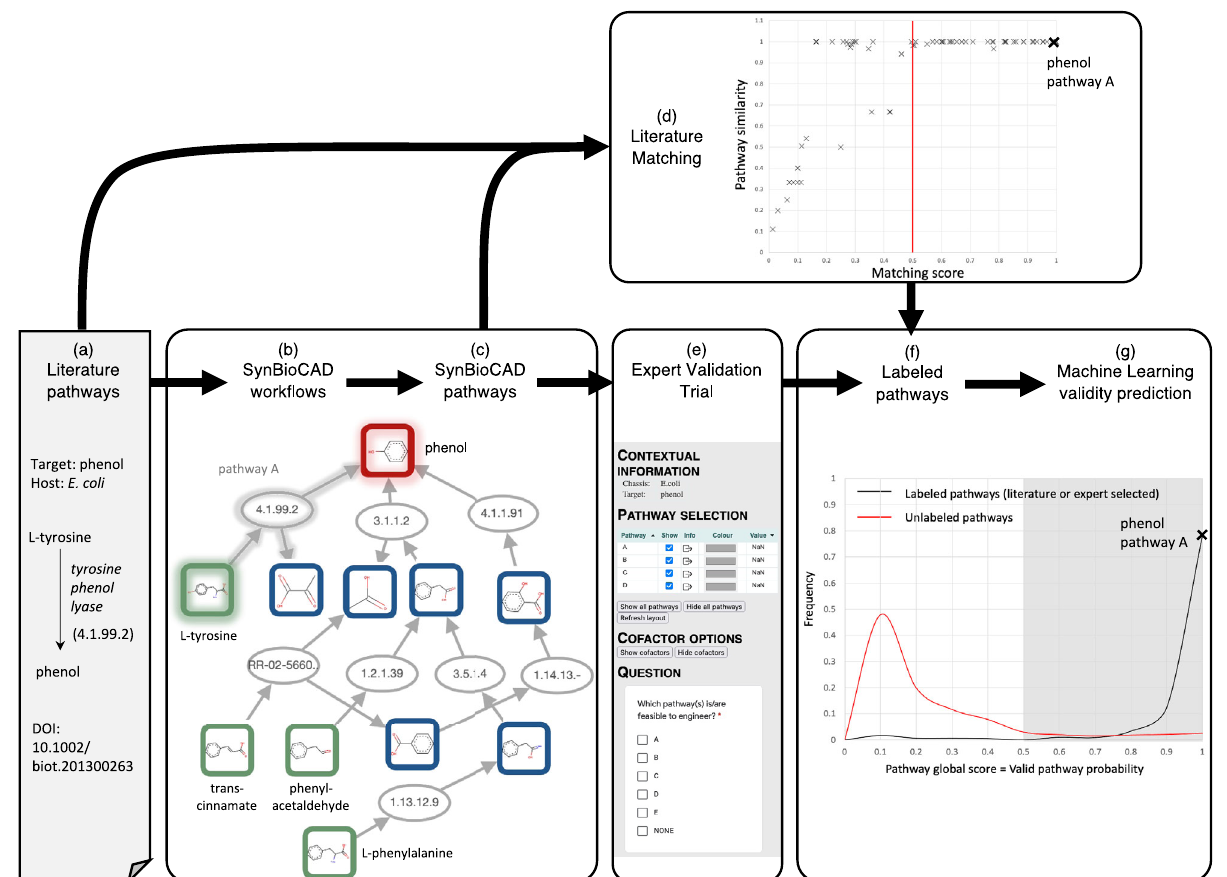
Fig. 2 | Scoring Galaxy-SynBioCAD predicted pathways with literature path- ways and expert validation data. a Pathways for different targets and different hosts are extracted from literature (cf. Literature data benchmarking subsection), this is illustrated here for production of phenol in E. coli . b Galaxy-SynBioCAD work fl ows are run on the literature targets and hosts. c A collection of Galaxy- SynBioCAD generated pathways is compiled. Pathway ‘ A ’ producing phenol in